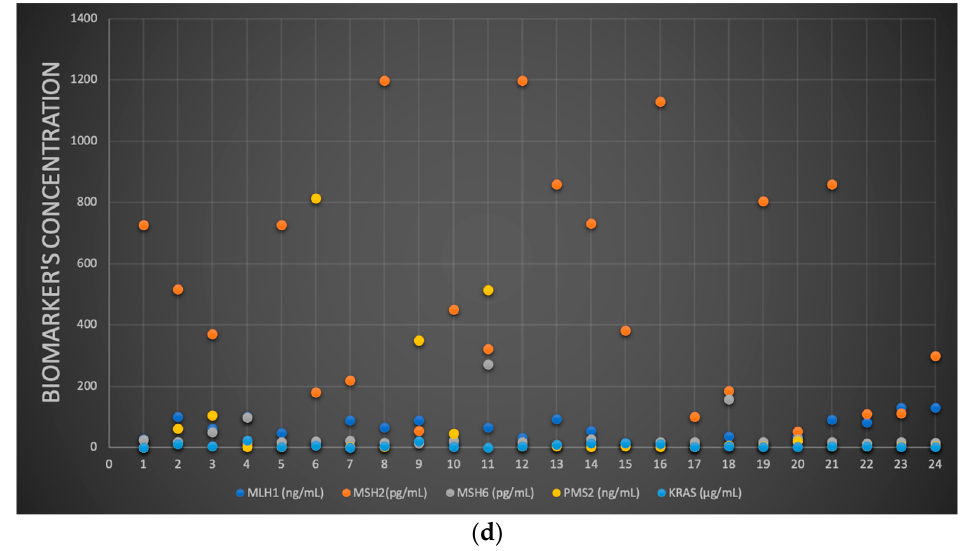
Figure 7. The results of the screening tests of ( a ) whole blood, ( b ) urine, ( c ) saliva and ( d ) tumoral tissue samples using the stochastic sensors based on MD/EGR-1.